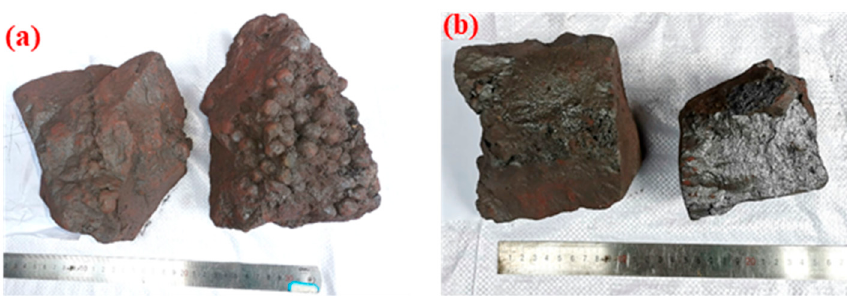
Figure 3. The massive deposit, including ( a ) loose type deposit; ( b ) tight type deposit.